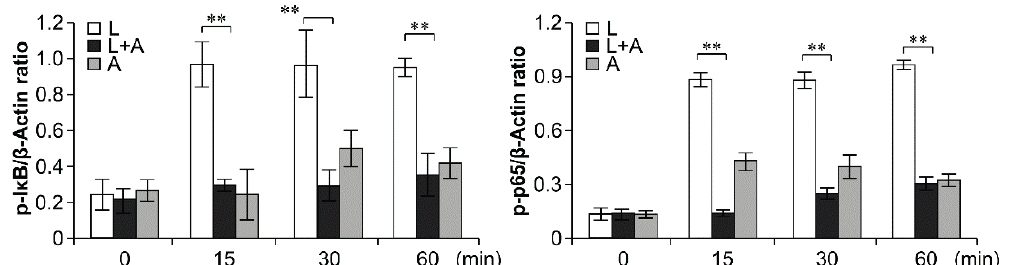
Figure 6. Western blot analysis for inhibition of LPS-induced NF- κ B activation by humanized anti-TLR4 Fab. Cells were pretreated with humanized anti-TLR4 antibody for 2 h and further incubated in presence or absence of LPS (1 µg/mL). After immunoblotting, the phosphorylation levels of IKK, I κ B, p65 were identified using phosphor-specific antibodies. β -Actin was used to ensure equal loading. L: LPS, A: humanized anti-TLR4 antibody. Data are shown as mean ± SD ( n = 3, ** p < 0.01 compare to LPS group).